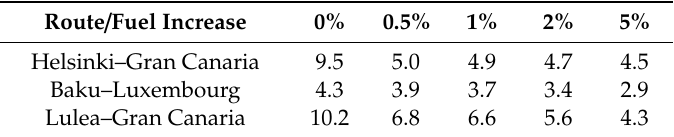
Table 1. Multiplier to CO 2 emissions in order to represent the total CO 2 and non-CO 2 climate impact for individual city pairs for relative fuel increases up to 5%.